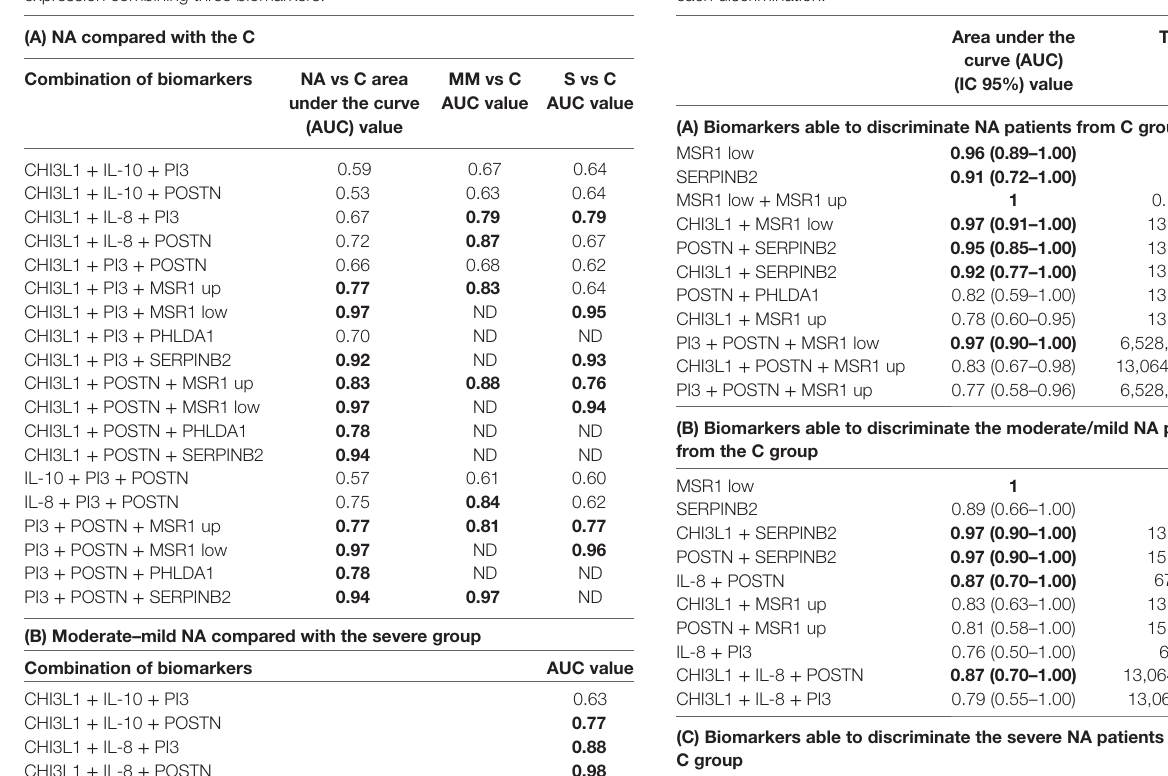
TaBle 5 | Ranking of the best individual and combined proteic biomarkers for each discrimination.